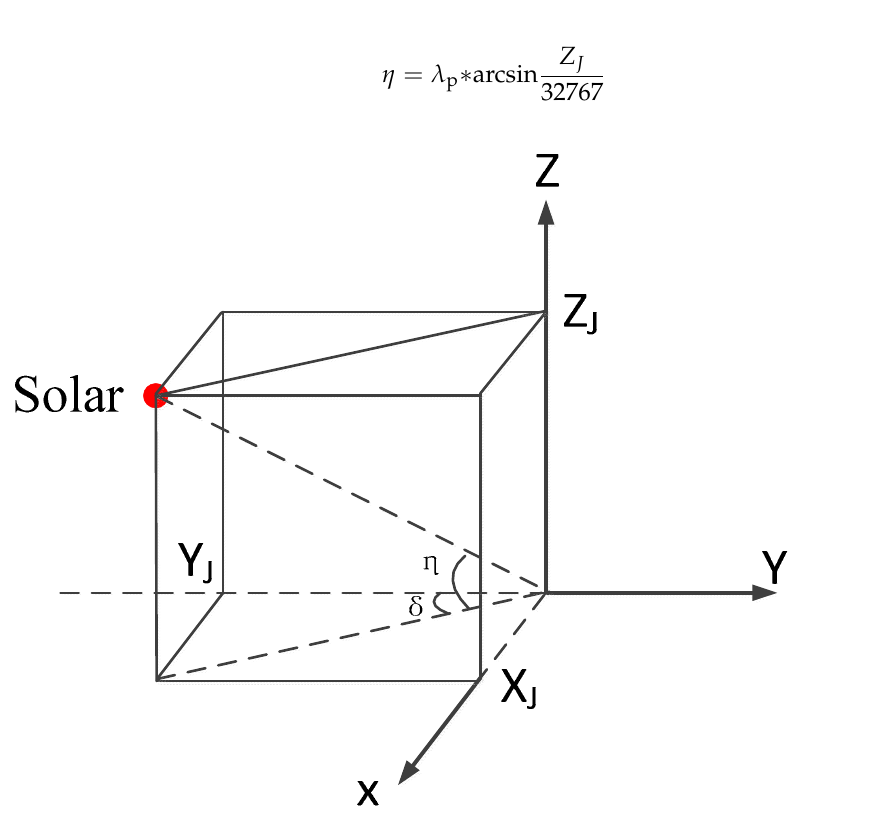
Figure 5. Sunlight azimuth and pitch angle in the guide-mirror coordinate system. The calculation and rectification of sunlight angles are very complex. When the solar- tracking simulation experiment on the ground is not sufficient, resulting in an inaccurate angle calculation, the SECCS dose not rectify the solar vector with Formulas (1)–(4) ac- cording to the injection instructions received in orbit, and the angle is directly calculated from the solar vector under the orbital coordinate system. The azimuth and pitch angle calculation processes, with sign rectification only, are shown in Formulas (7) and